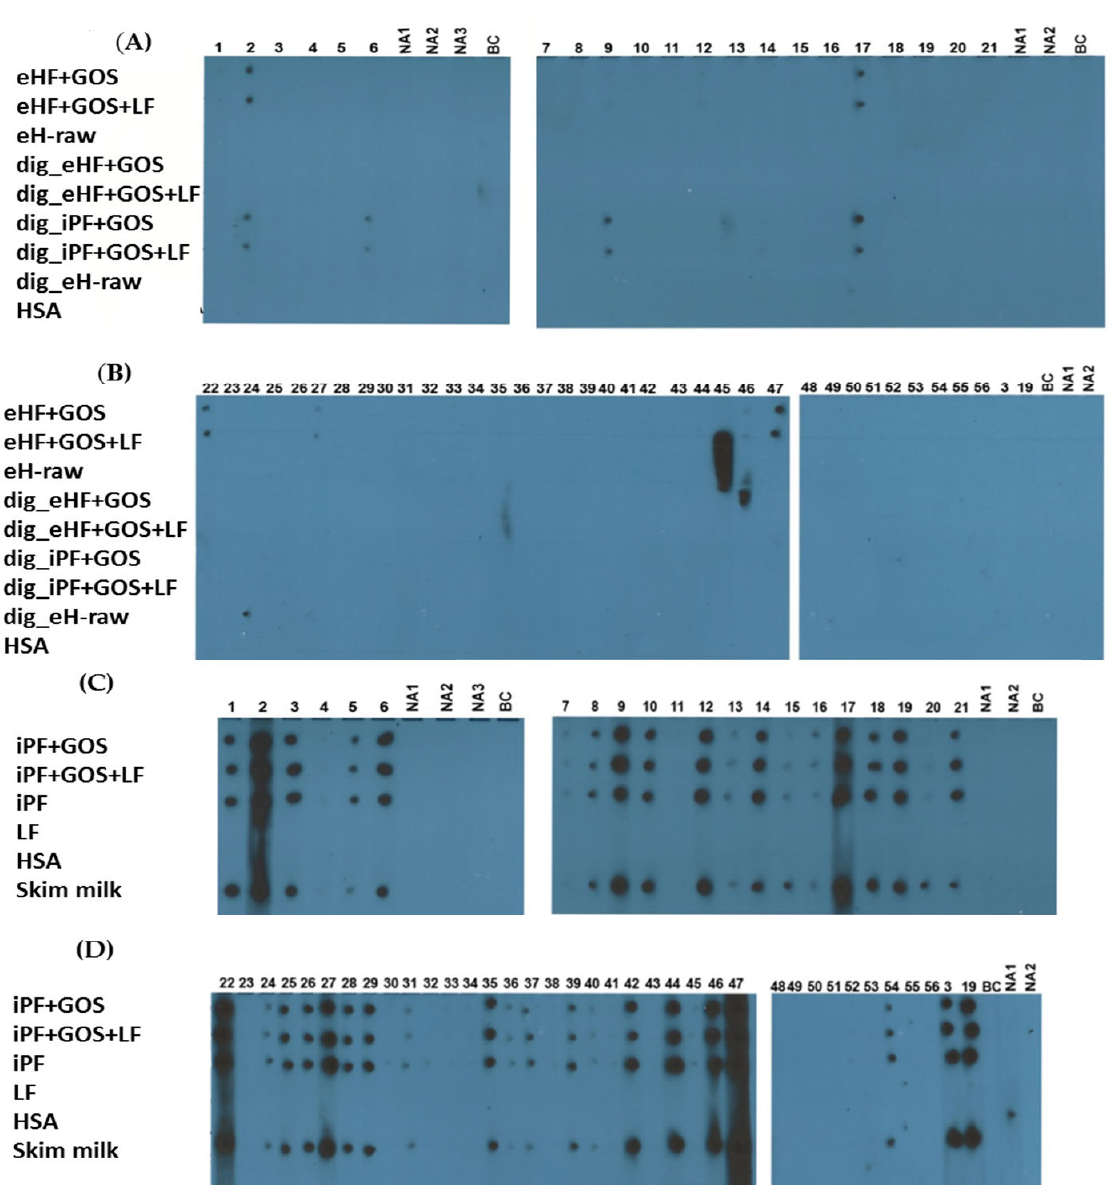
Figure 2. IgE reactivity to dot-blotted infant formulas or materials. ( A – D ) Dot-blotted infant formulas or materials (left; details described in Table 2) were exposed to sera from cow’s milk-allergic patients (1–56), sera from non-allergic subjects (NA1, NA2), or buffer alone ( B , C ). Bound IgE antibodies were detected with 125 I-labeled anti-human IgE antibodies and visualized by autoradiography.